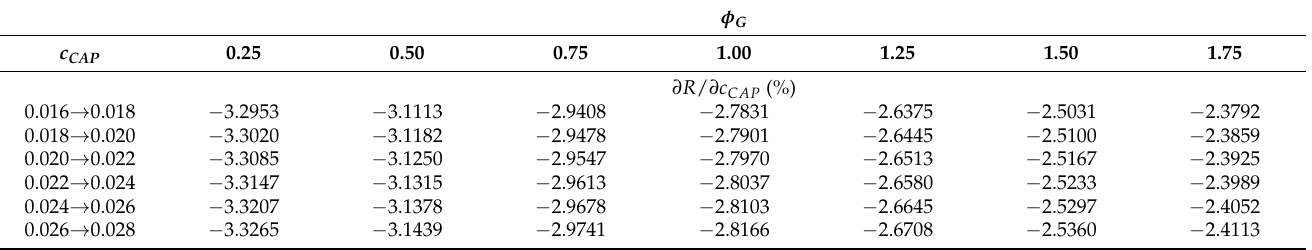
Table 3. Responsiveness of the optimal guaranteed rate to c CAP at various gray rhino levels.